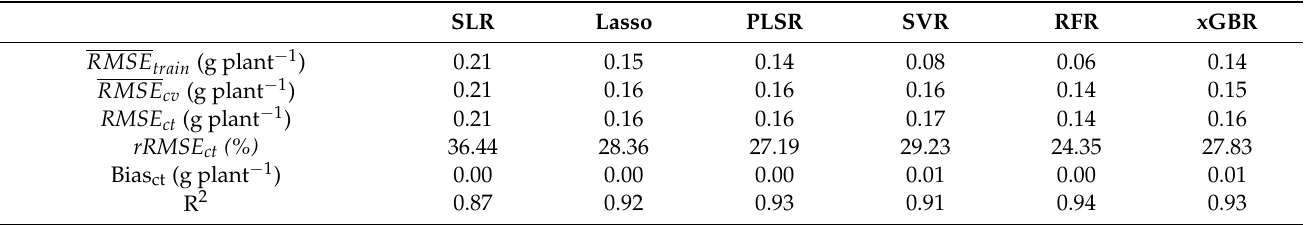
Table A2. Model training performance using randomized Kfold-CV for the prediction of the leek N-uptake using the data from the 2019